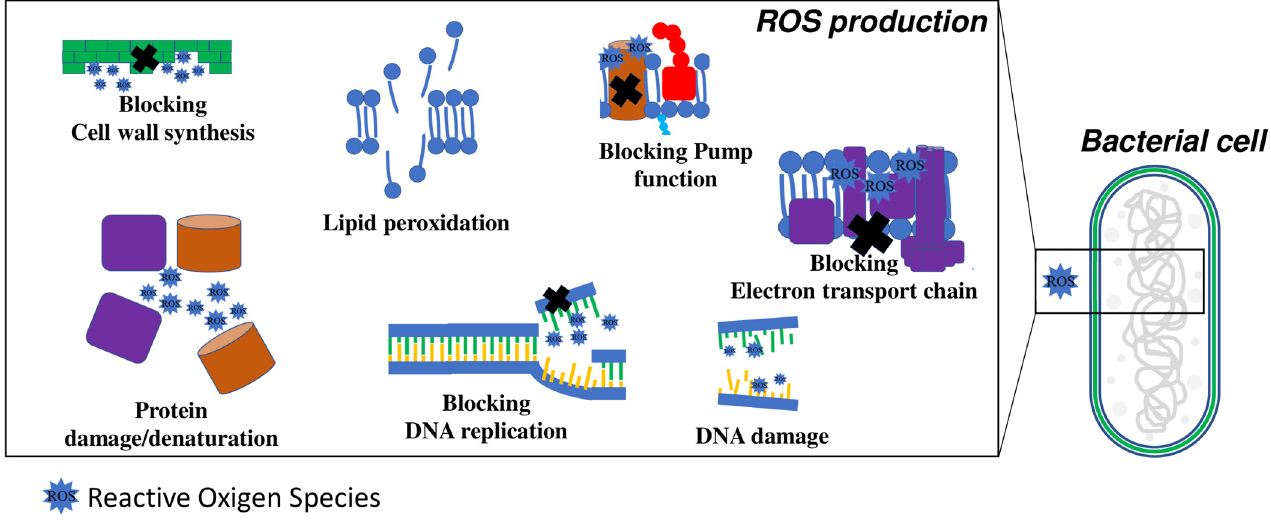
Figure 5. Schematic description and targets of antibacterial mechanisms due to the ROS produced by nanoparticles (NPs).